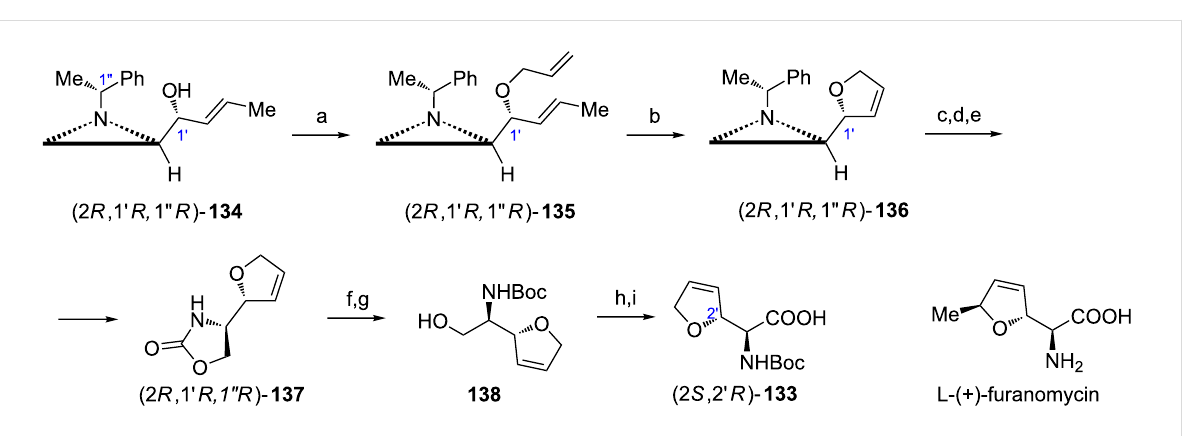
Scheme 35: Synthesis of N -Boc-norfuranomycin ((2 S ,2' R )- 133 ). Reagents and conditions: a) H 2 C=CHCH 2 I, NaH, THF, 0 °C to rt, 3 h; b) Grubbs' 1st,